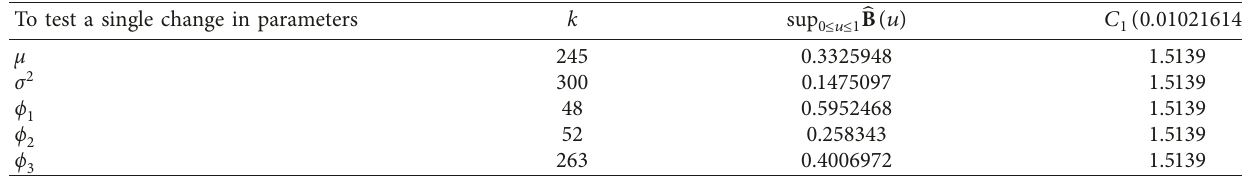
1 . (d) ϕ 2 . (e) ϕ 3 . , ϕ , and ϕ . 1 2 3